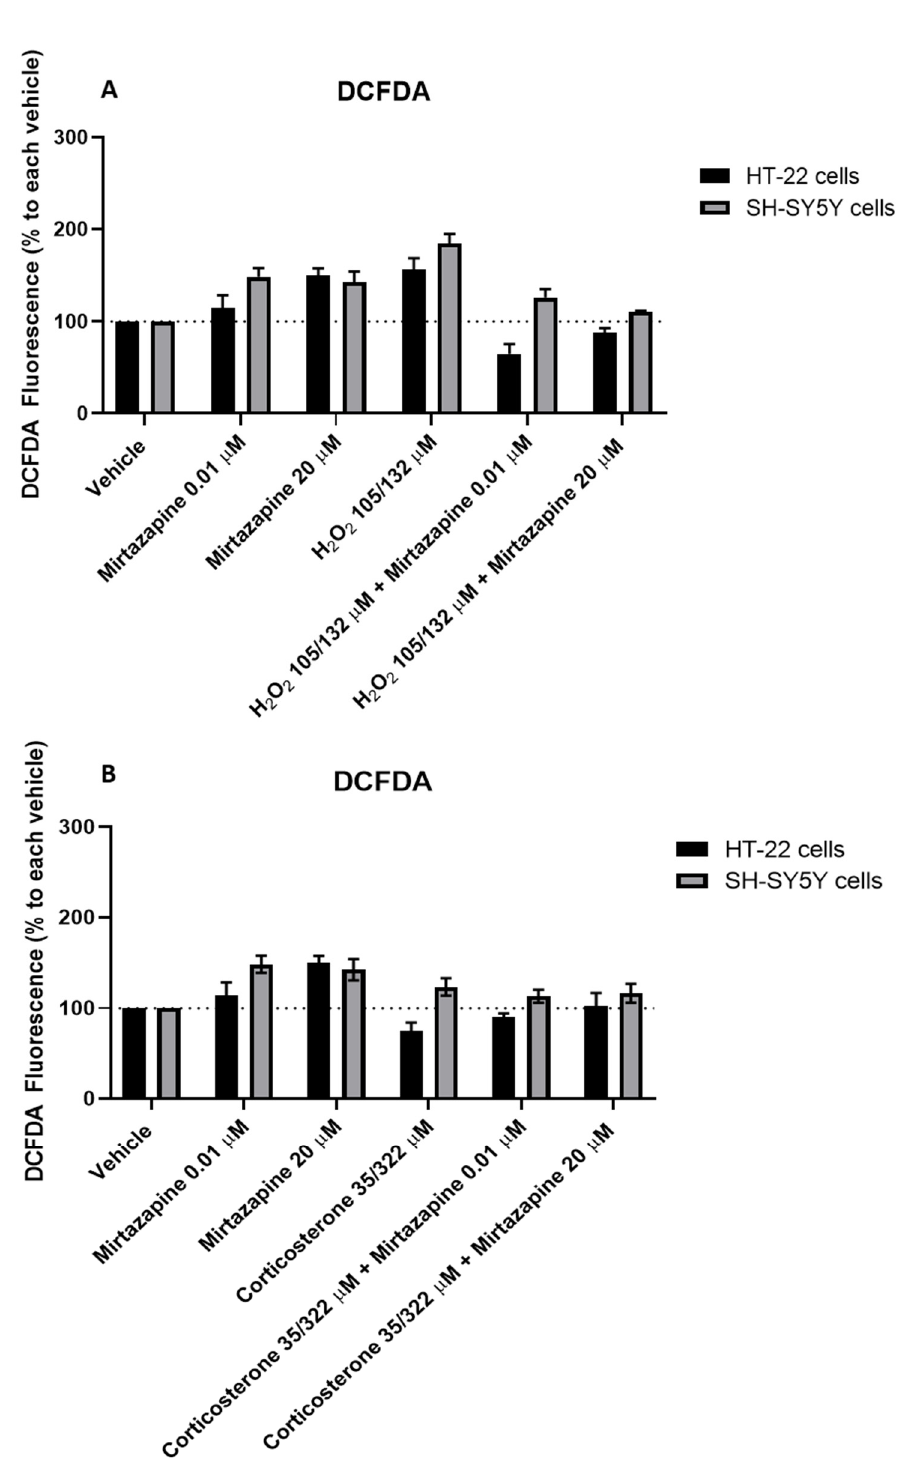
The results represent the mean ± SEM of 2–6 independent experiments, expressed as the percentage of each vehicle (100%) for each period. Statistically significant * p < 0.05, ** p < 0.01, *** p < 0.001, and **** p < 0.0001 vs. vehicle, for each time.